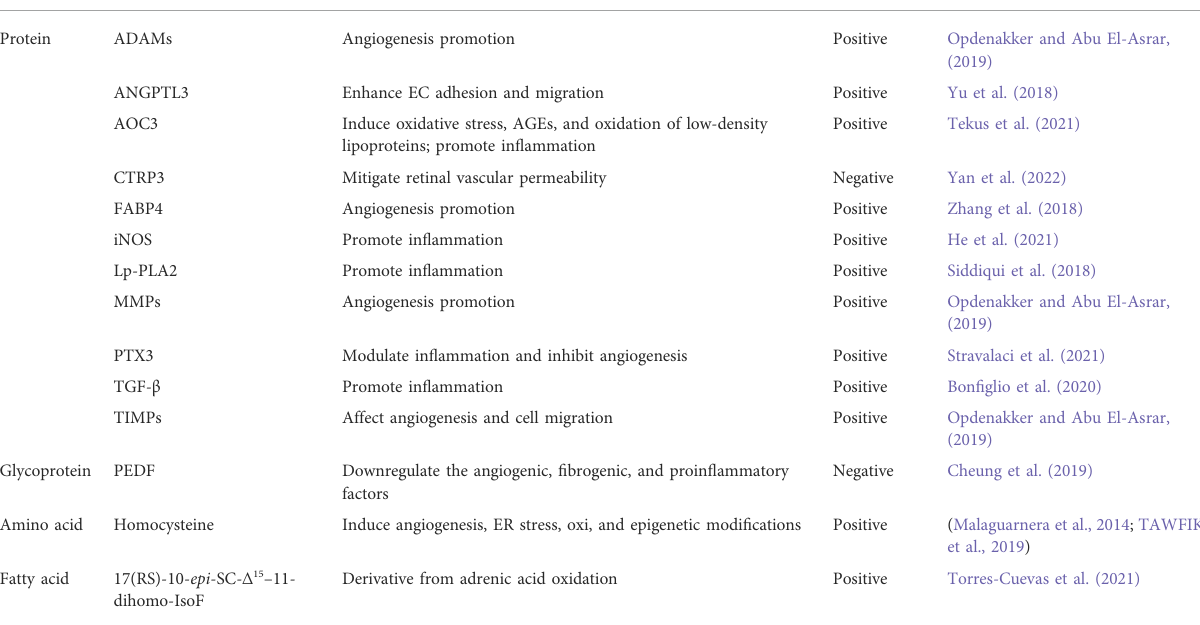
TABLE 2 Blood metabolic